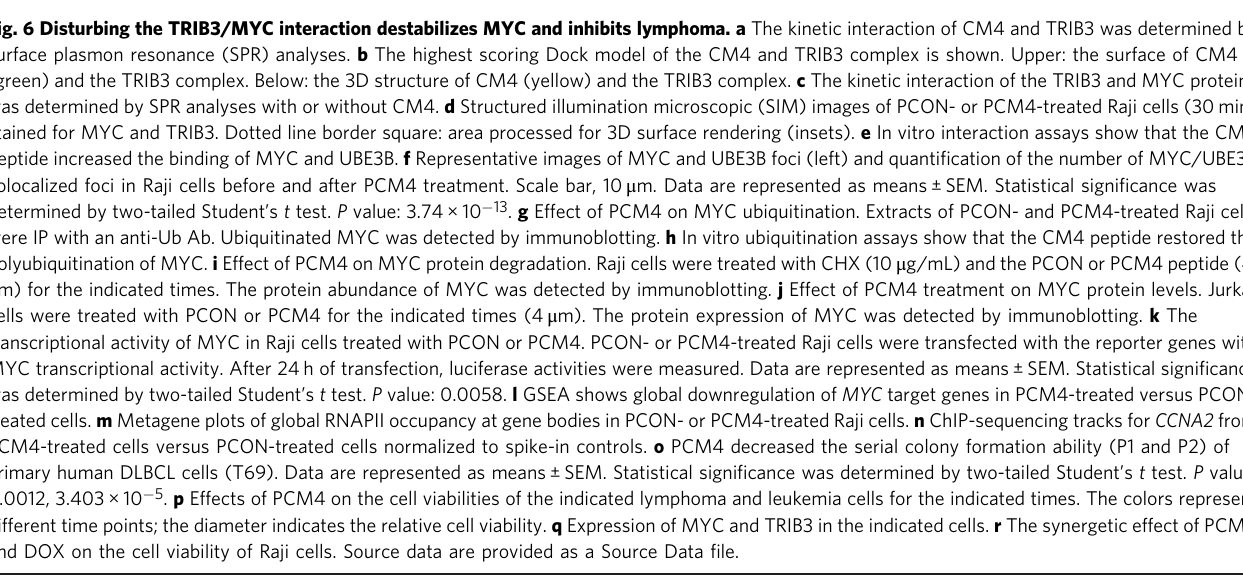
Fig. 6 Disturbing the TRIB3/MYC interaction destabilizes MYC and inhibits lymphoma. a The kinetic interaction of CM4 and TRIB3 was determined by surface plasmon resonance (SPR) analyses. b The highest scoring Dock model of the CM4 and TRIB3 complex is shown. Upper: the surface of CM4 (green) and the TRIB3 complex. Below: the 3D structure of CM4 (yellow) and the TRIB3 complex. c The kinetic interaction of the TRIB3 and MYC proteins was determined by SPR analyses with or without CM4. d Structured illumination microscopic (SIM) images of PCON- or PCM4-treated Raji cells (30 min) stained for MYC and TRIB3. Dotted line border square: area processed for 3D surface rendering (insets). e In vitro interaction assays show that the CM4 peptide increased the binding of MYC and UBE3B. f Representative images of MYC and UBE3B foci (left) and quanti fi cation of the number of MYC/UBE3B colocalized foci in Raji cells before and after PCM4 treatment. Scale bar, 10 μ m. Data are represented as means ± SEM. Statistical signi fi cance was determined by two-tailed Student ’ s t test. P value: 3.74 × 10 − 13 . g Effect of PCM4 on MYC ubiquitination. Extracts of PCON- and PCM4-treated Raji cells were IP with an anti-Ub Ab. Ubiquitinated MYC was detected by immunoblotting. h In vitro ubiquitination assays show that the CM4 peptide restored the polyubiquitination of MYC. i Effect of PCM4 on MYC protein degradation. Raji cells were treated with CHX (10 μ g/mL) and the PCON or PCM4 peptide (4 μ m) for the indicated times. The protein abundance of MYC was detected by immunoblotting. j Effect of PCM4 treatment on MYC protein levels. Jurkat cells were treated with PCON or PCM4 for the indicated times (4 μ m). The protein expression of MYC was detected by immunoblotting. k The transcriptional activity of MYC in Raji cells treated with PCON or PCM4. PCON- or PCM4-treated Raji cells were transfected with the reporter genes with MYC transcriptional activity. After 24 h of transfection, luciferase activities were measured. Data are represented as means± SEM. Statistical signi fi cance was determined by two-tailed Student ’ s t test. P value: 0.0058. l GSEA shows global downregulation of MYC target genes in PCM4-treated versus PCON- treated cells. m Metagene plots of global RNAPII occupancy at gene bodies in PCON- or PCM4-treated Raji cells. n ChIP-sequencing tracks for CCNA2 from PCM4-treated cells versus PCON-treated cells normalized to spike-in controls. o PCM4 decreased the serial colony formation ability (P1 and P2) of primary human DLBCL cells (T69). Data are represented as means ± SEM. Statistical signi fi cance was determined by two-tailed Student ’ s t test. P value: 0.0012, 3.403 × 10 − 5 . p Effects of PCM4 on the cell viabilities of the indicated lymphoma and leukemia cells for the indicated times. The colors represent different time points; the diameter indicates the relative cell viability. q Expression of MYC and TRIB3 in the indicated cells. r The synergetic effect of PCM4 and DOX on the cell viability of Raji cells. Source data are provided as a Source Data fi